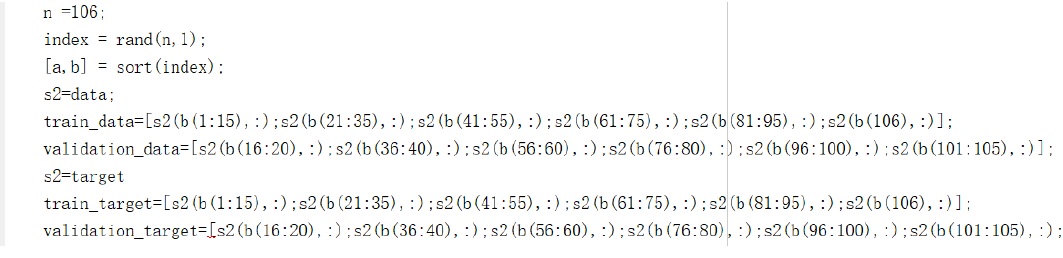
Figure A2. The architecture of convolutional neural network (CNN). References 1.